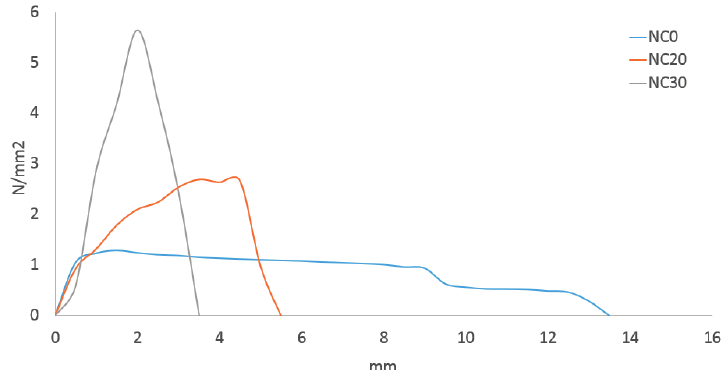
Figure 3. Stress strain graph for fish scale biopolymer films loaded with 0, 20 and 30 g